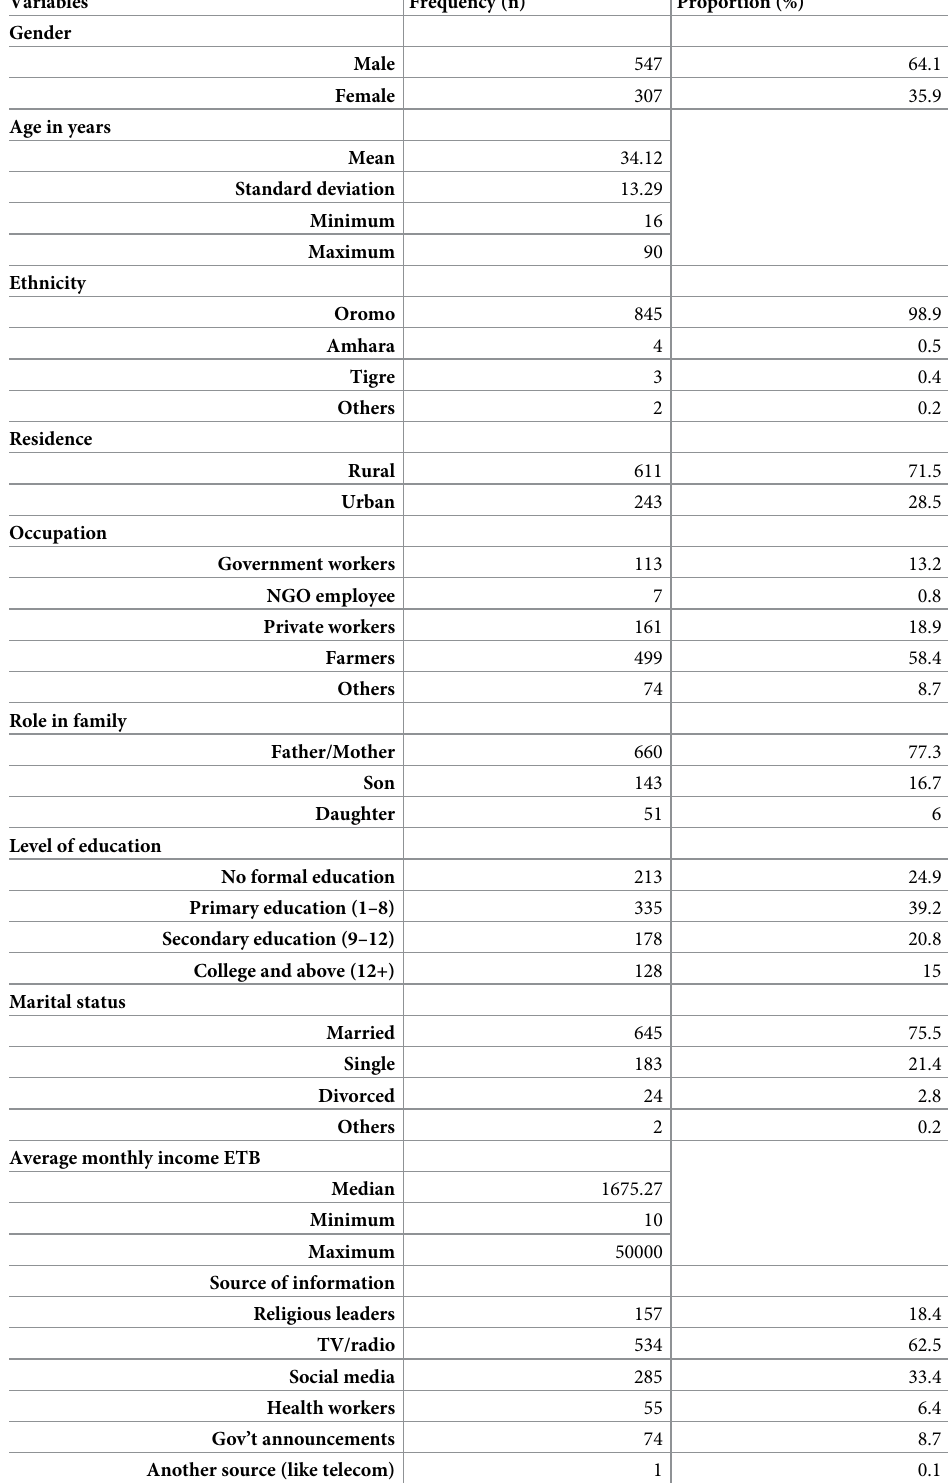
Table 1. Sociodemographic characteristics of study